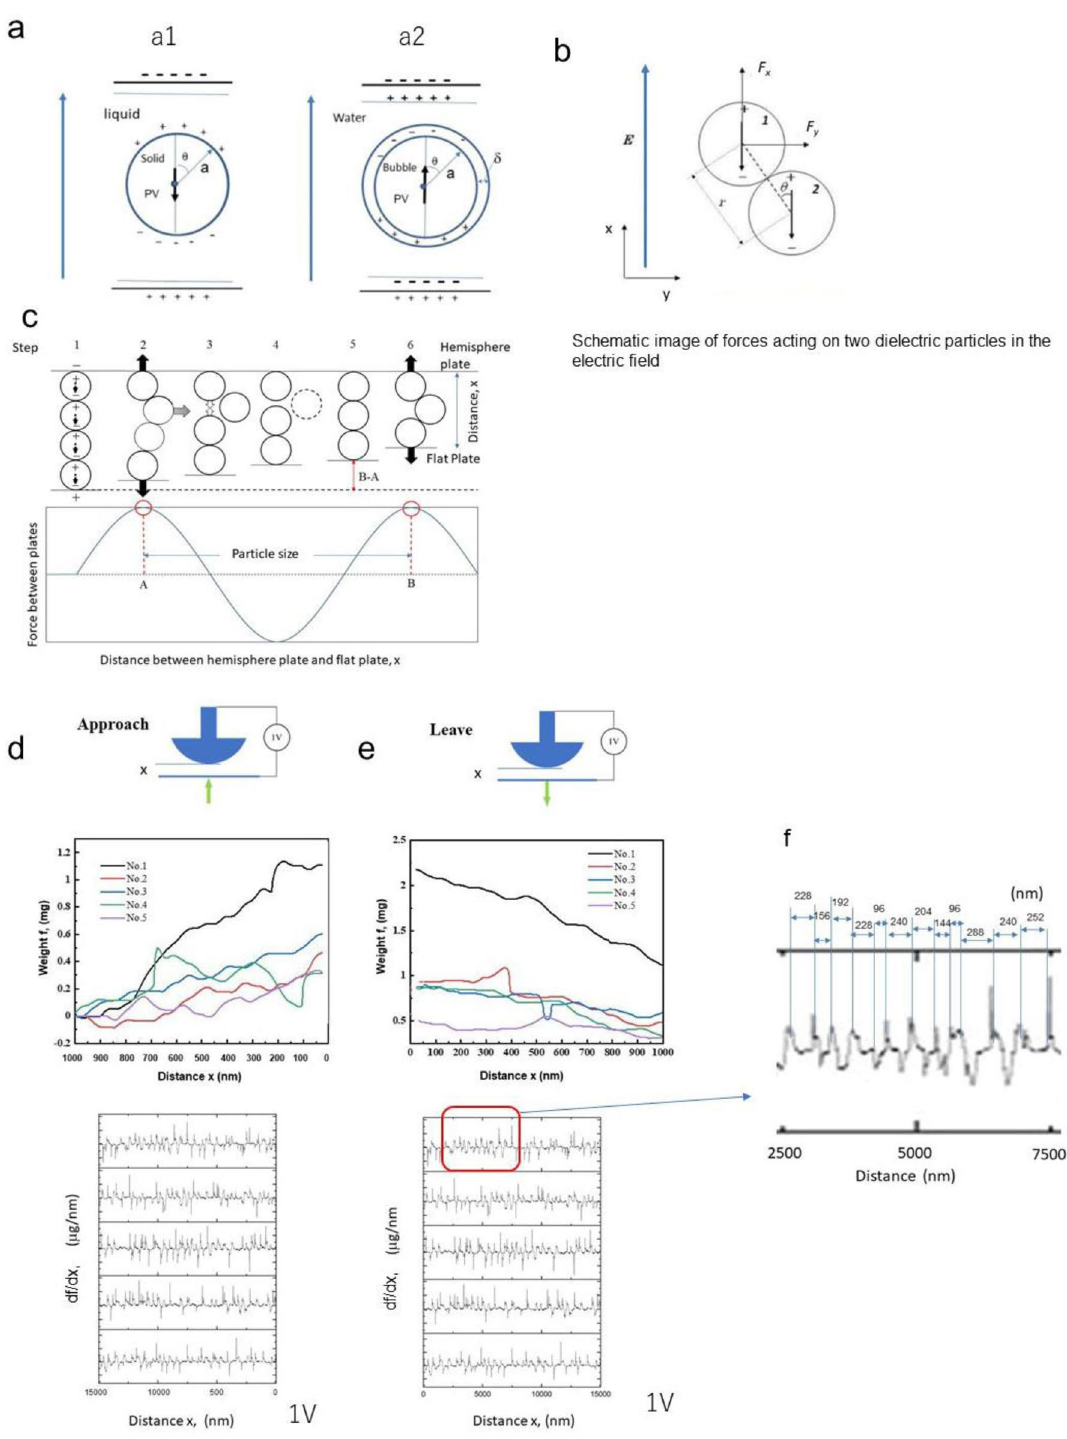
Figure 2. Particle interaction and movement and measured force. ( a ) ( a1 ) shows a model of a solid particle in a fluid under an electric field, and ( a2 ) shows a model of a nanobubble in water under an electric field. δ is the cover layer of the bubble. There are some explanations as the covered layer was discussed using Table S2. Here, the electrical double-layer and hydrogen bonds would be mainly affected. ( b ) Contacted two spherical particles with an induced electric dipole moment in the centre of the particle under an electric field. ( c ) The model shows the changing positions of four to three spherical particles by decreasing the distance between two electrodes. The model below shows the force change between two electrode plates by changing the particle positions. ( d ) The top figure shows two electrode plates sandwiching nanobubbles containing fluid approach. The weight results measured by the balance were converted to the force value using Eq. (2). The second figure shows the weight as the interactive force “ f ” of the electric balance shown in Fig. 1a, depending on the decreasing distance x under 1 voltage. More than 5 measurements were taken. The third figure shows “d f /d x ” depending on x. ( e ) The top figure shows that two electrode plates sandwiching nanobubbles containing fluid leave. The second figure shows the weight “ f ” of the electric balance shown in Fig. 1a depending on the increasing distance x under 1 voltage. Five measurements were taken. The third figure shows “d f /d x ” depending on x . ( f ) Enlarged view of “d f /d x ”. The peak-to-peak distance shows the particle